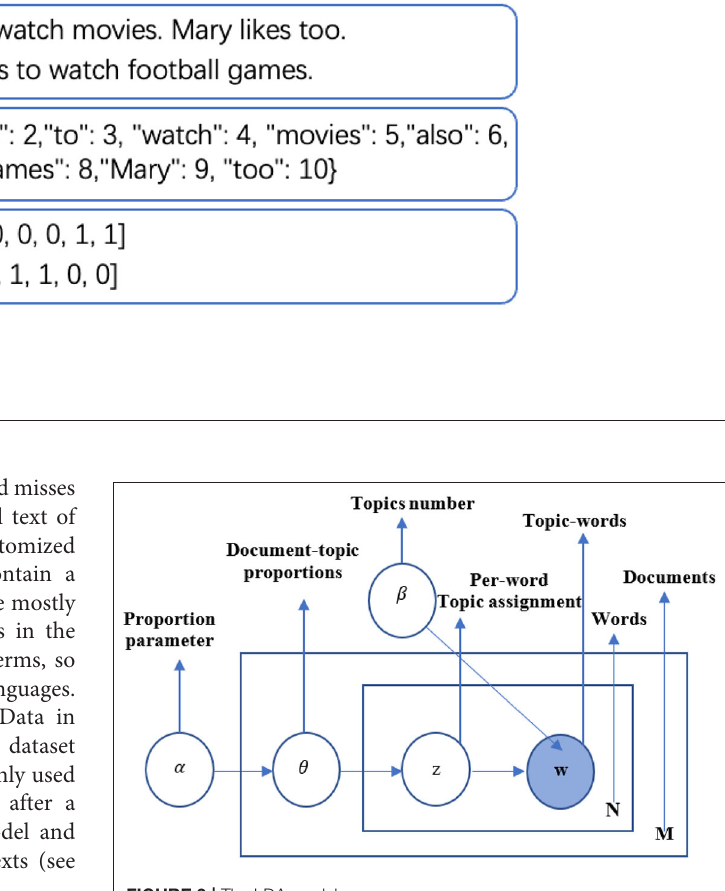
FIGURE 3 | The LDA